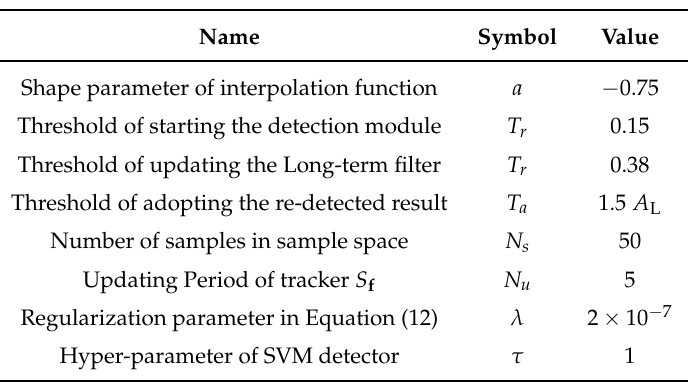
Table 2. Parameters of